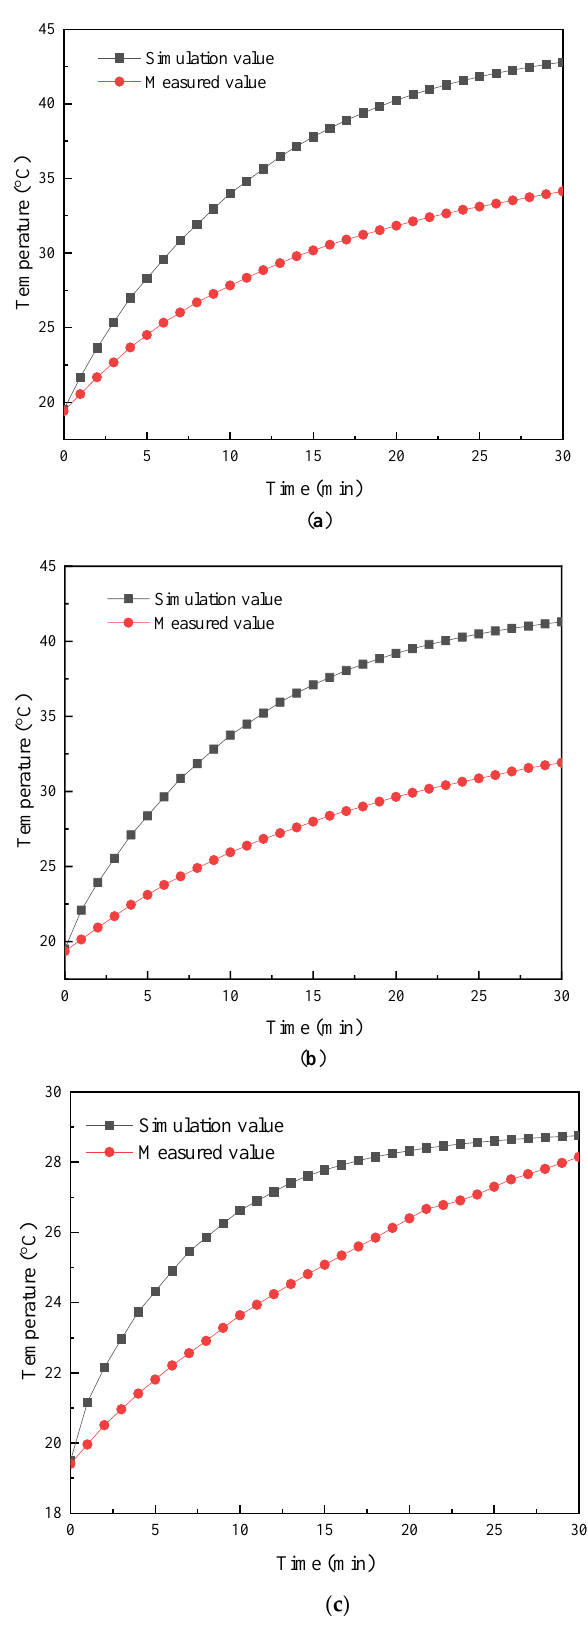
Figure 7. Temperature variation curve of Terfenol-D rods with time: ( a ) untreated; ( b ) radial slit; ( c ) sliced at both ends.